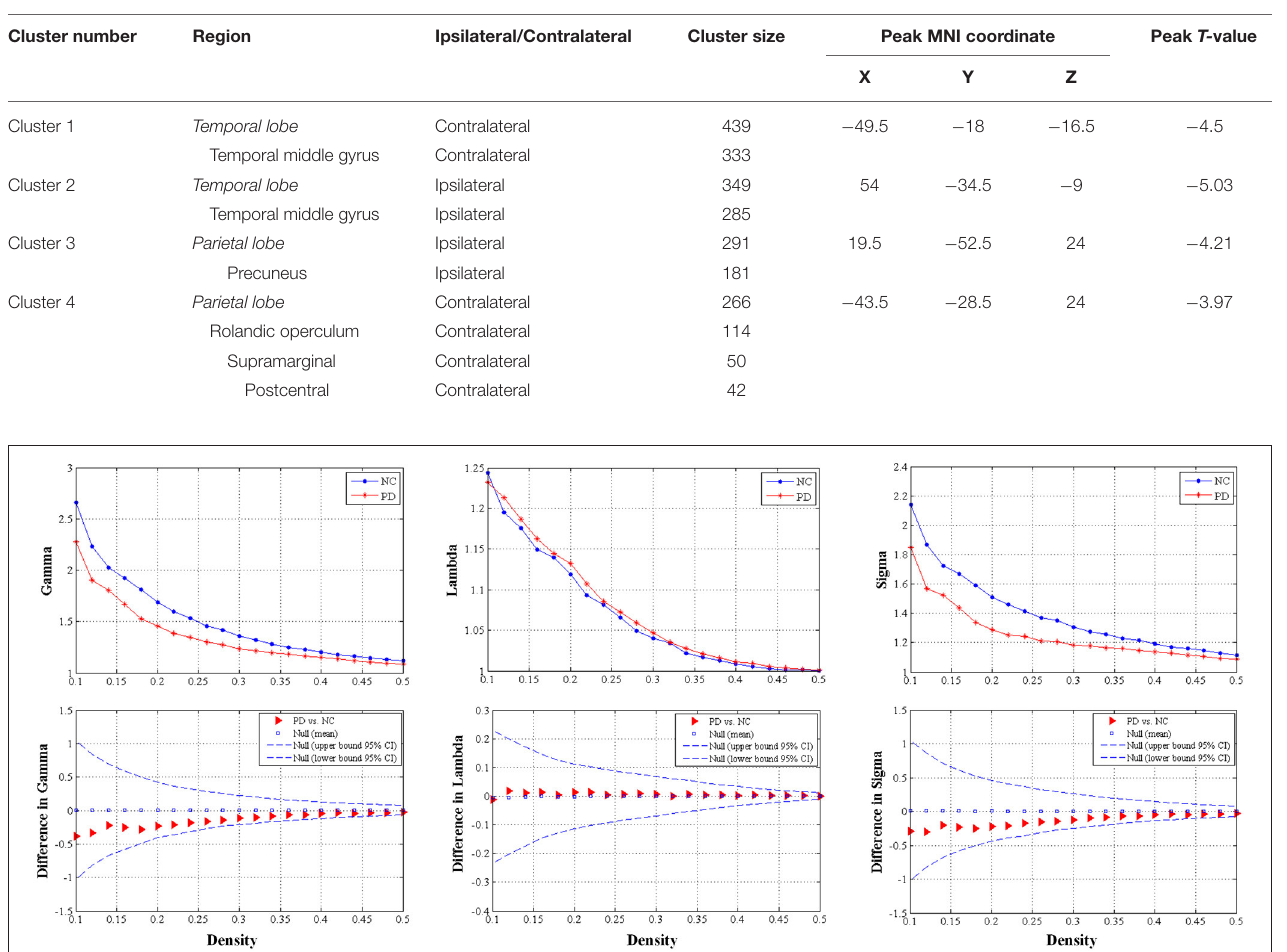
TABLE 2 | Regional brain atrophy in patients with Parkinson’s disease compared with normal controls. Cluster number